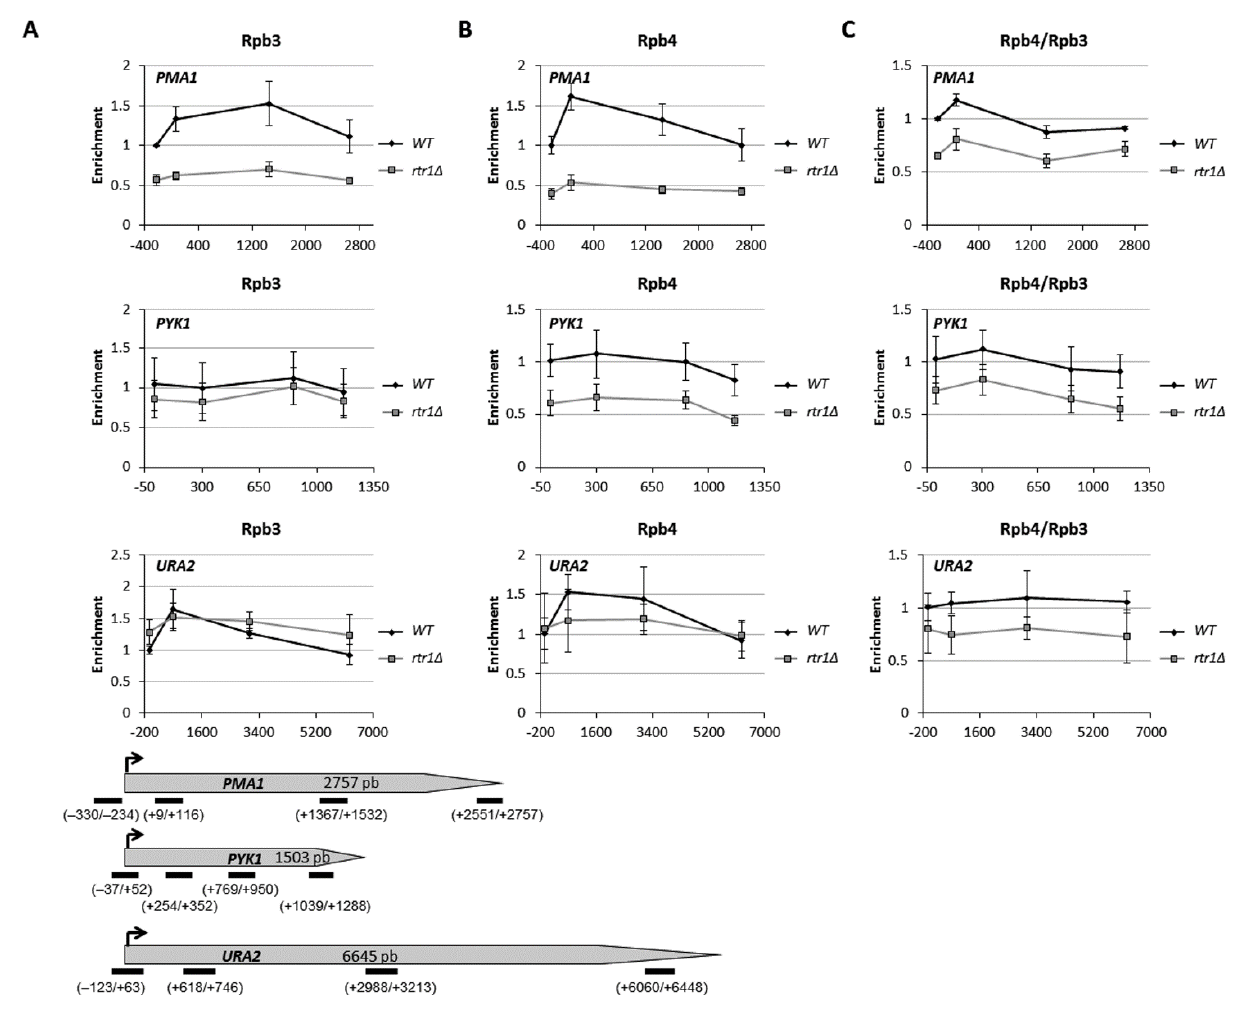
Figure 3. rtr1 ∆ mutation affects gene occupancy by RNA pol II, but not global Rpb4 dissociation. Chromatin immunoprecipitation (ChIP) analysis for different genes in wild-type and rtr1 ∆ cells, performed with anti-Rpb3 ( A ) and anti-Rpb4 ( B ) antibodies, against Rpb3 and Rpb4 RNA pol II subunits. ( C ): Rpb4/Rpb3 ratios for Rpb4 dissociation analysis, from left and middle panel’s results. Lower panel: transcription units used in this work indicating location of analyzed PCR amplicons. Values found for immunoprecipitated PCR products were compared to those of total input, and ratio of each PCR product of transcribed genes to a nontranscribed region of chromosome V was calculated.